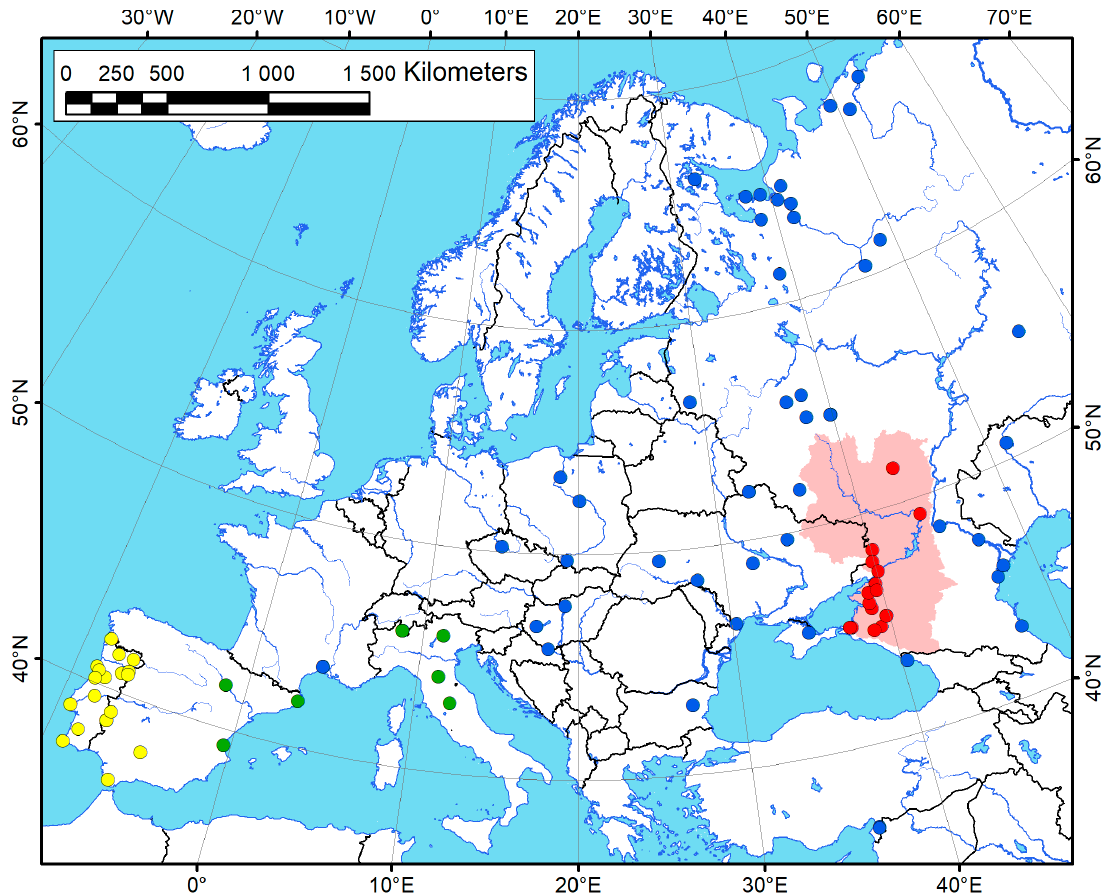
Figure 1. Map showing the location of Anodonta anatina samples from Europe (our data; samples from NCBI GenBank). Point colors represent following lineages: IBER—Iberia lineage, yellow; EUR—Eurasian (recent) lineage, blue; AZOV—Azov lineage, red; ITAL—Italian lineage + Ebro, green (Table S1). Pink color indicates basins of following rivers: Kuban, Don, Kagalnik, Kirpili, Yeya, Chelbas, Beisug. The map was created using ESRI ArcGIS 10 software (https://www.esri.com/arcgis); the topographic base of the map was created with Natural Earth Free Vector and Raster Map Data (https://www.naturalearthdata.com) and HydroSHEDS (https://www.hydrosheds.org) (Map: Mikhail Yu. Gofarov).